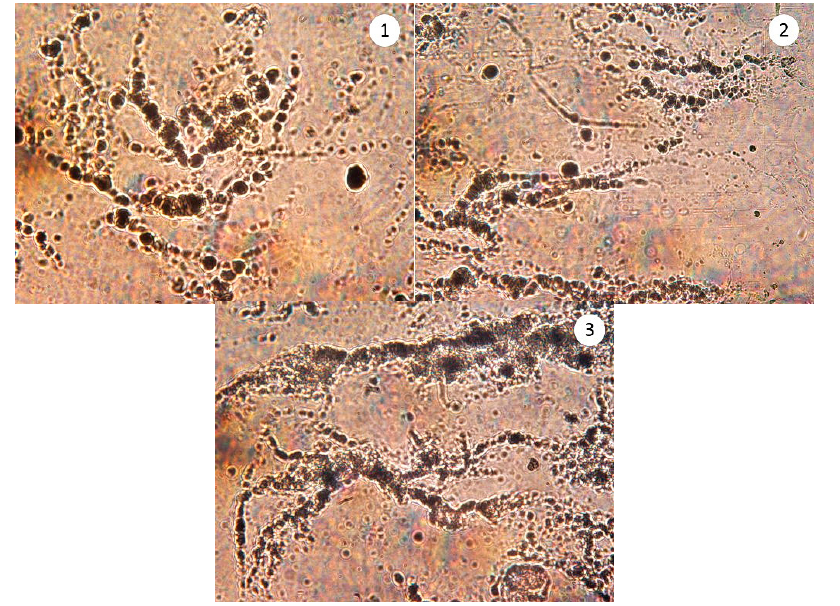
Figure 7. Optic microscope images (×10) of PVA-BC 12/6 (1), PVA-BC 12/12 (2) and PVA-BC 12/18 (3) mixtures before the start of membrane cross-linking.